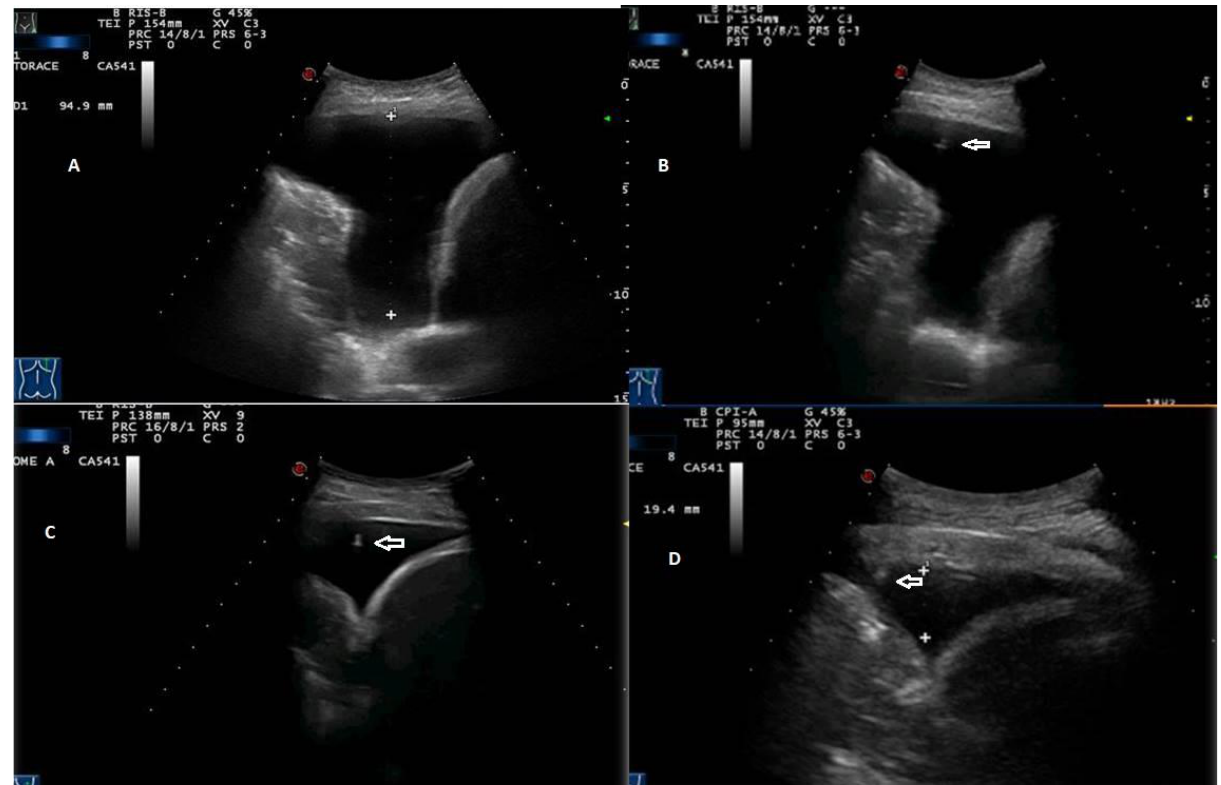
Figure 7. Stages of TUS-assisted thoracentesis . ( A ) Initial pleural effusion’s measurement using a convex 3.5 MHz holed probe. ( B – D ) Progressive lung re-expansion during drainage. The position of the needle tip (white arrows) is highlighted during all phases of the procedure until the needle is retracted.